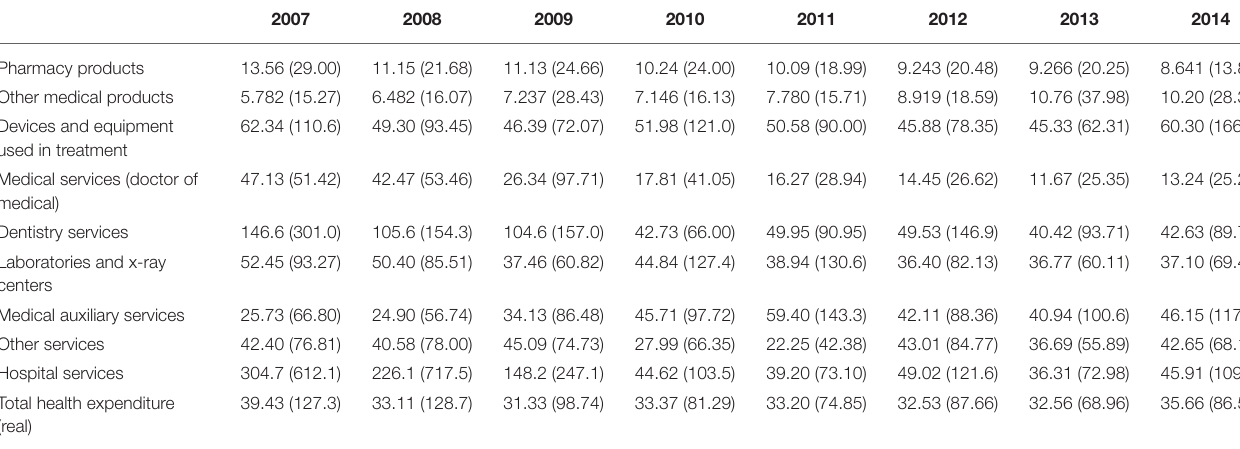
TABLE 2 | Health expenditure ratios of households with positive health expenditure (%).